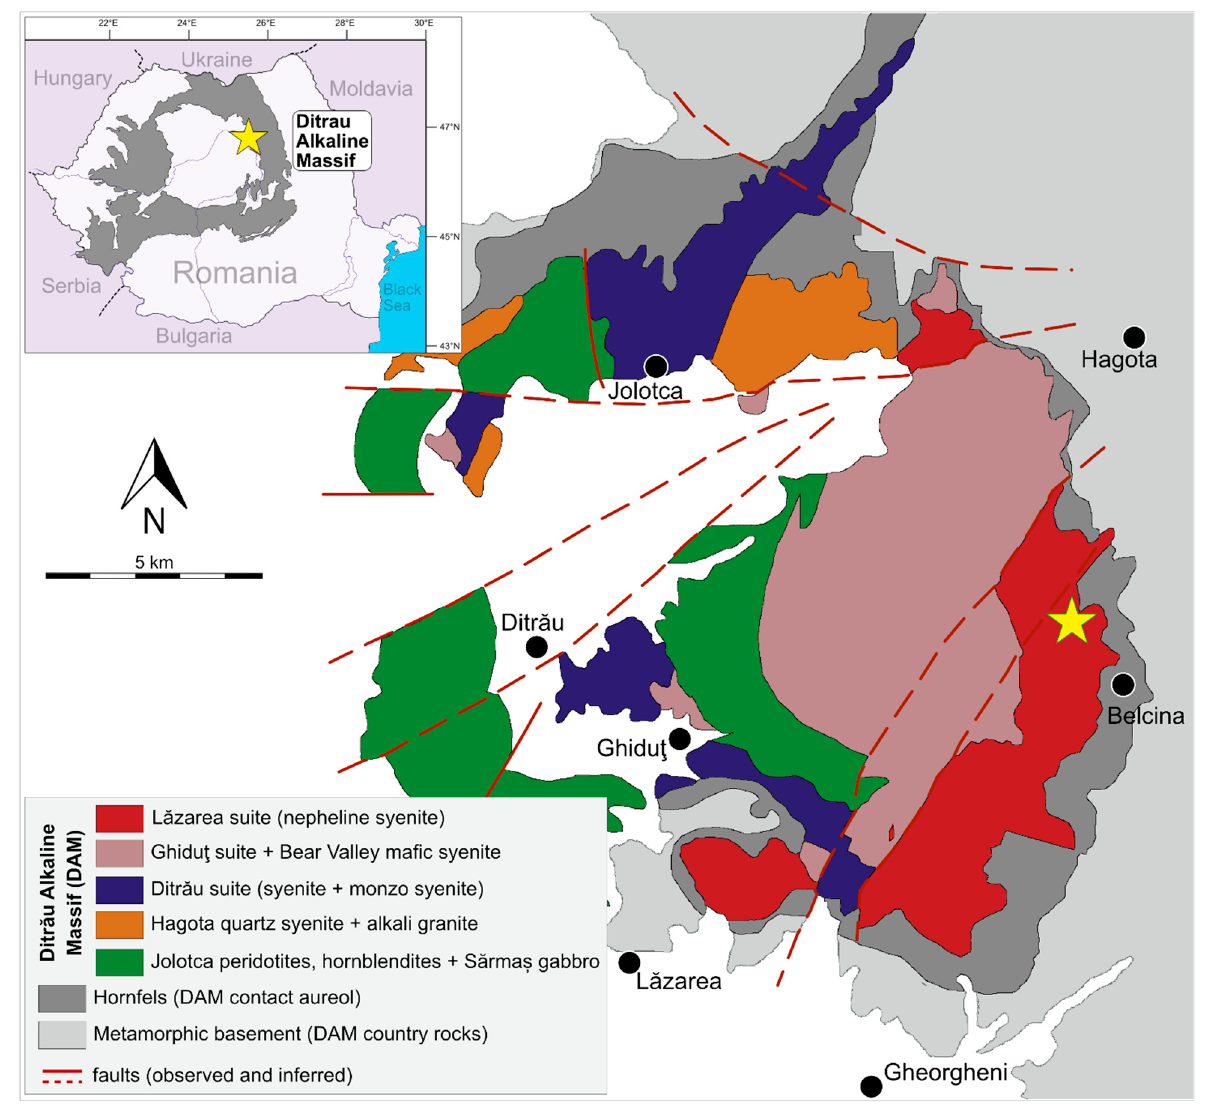
Figure 1. Geological map of the Ditr ă u Alkaline Massif (DAM) after [17,18]. The location of samples Ditr ǎ u 1 (L ă zarea suite) and Ditr ă u 2 (Ghidu ţ suite) are indicated by the yellow star. The inset shows the position of the Ditr ă u Alkaline Massif within the Eastern Carpathians of Romania.